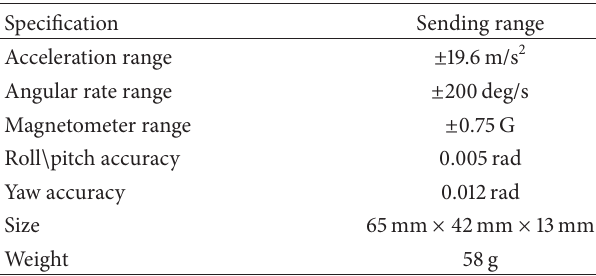
Table 4: Specifications of damping